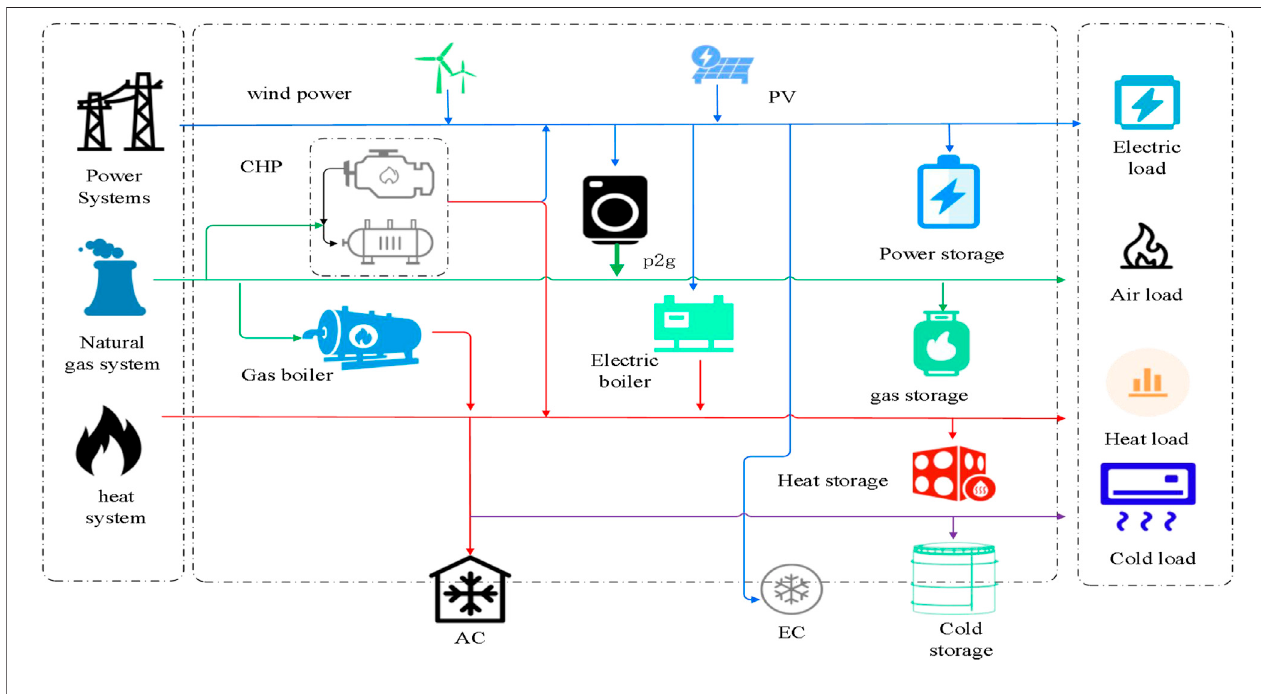
FIGURE 1 | Typical structure of IES.